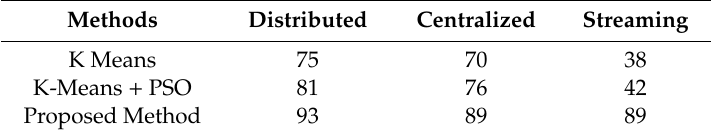
Table 6. Clustering and analyzing accuracy of di ff erent source format of